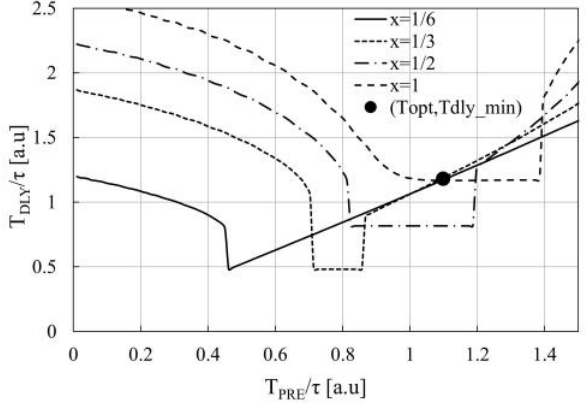
Figure 4. T DLY as a function of T PRE for x = 1/6, 1/3, 1/2, and 1.